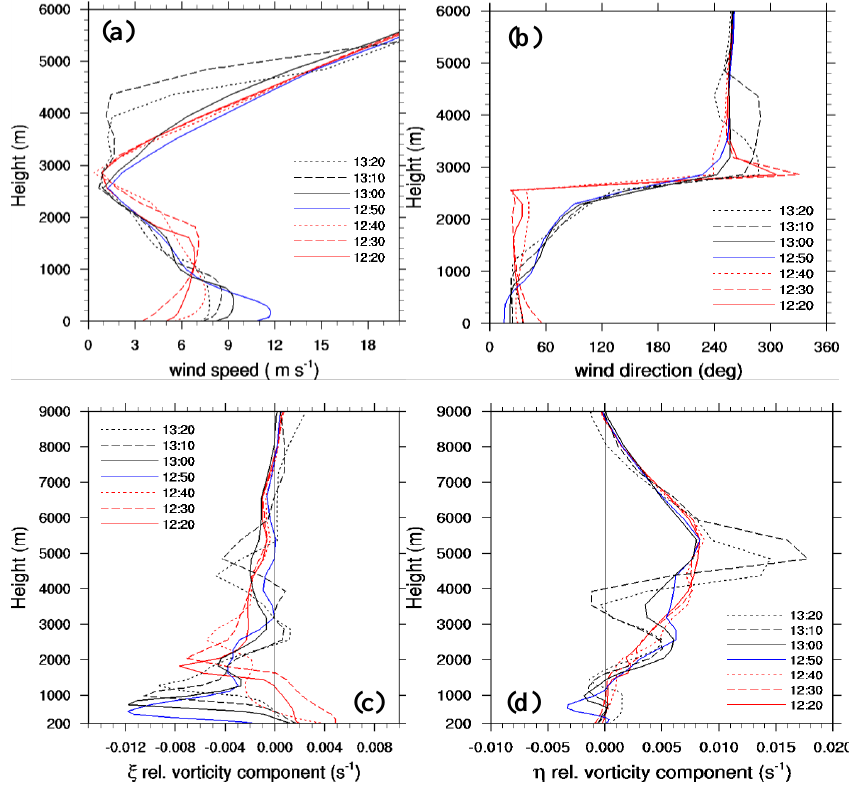
Fig. 6. Vertical profiles at lat = 31.81, lon =− 4.39 during the passage of the storm (12:20–13:20) on 31 May 2006. (a) Wind speed (ms − 1 ) .